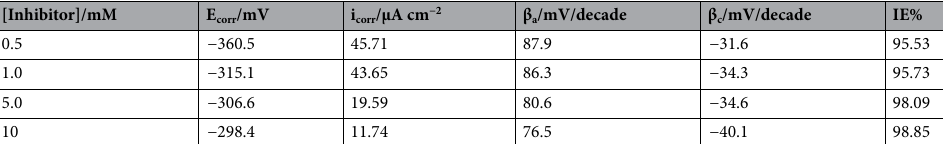
Table 3. Electrochemical corrosion parameters of Mo electrode as a function of inhibitor concentration in 3.0 M phosphoric acid containing 1.0 M NaCl at 298